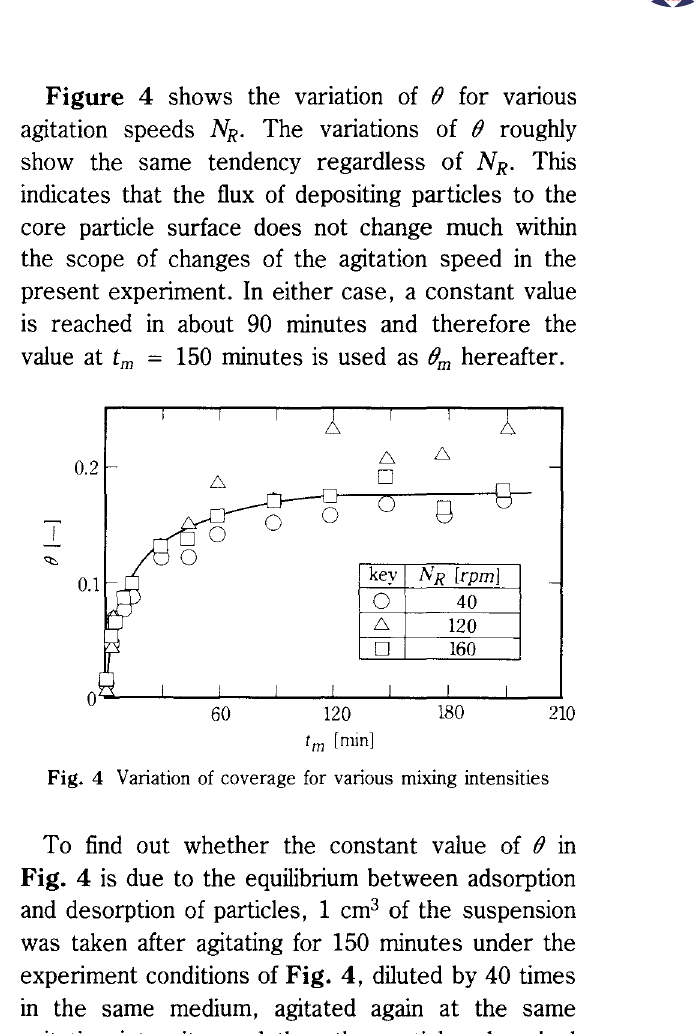
Fig. 4 Variation of coverage for various mixing intensities To find out whether the constant value of (J in Fig. 4 is due to the equilibrium between adsorption and desorption of particles, 1 cm 3 of the suspension was taken after agitating for 150 minutes under the experiment conditions of Fig. 4, diluted by 40 times in the same medium, agitated again at the same agitation intensity, and then the particles desorbed from the core particle was counted. The results are shown in Fig. 5. Here, since the diluting factor is sufficiently large, the re-deposition of desorbed particles will be neglected. The positive value of the desorption ratio a indicates the particle desorption by agitation. At any agitation speed, and any agitation time td, the value of a is approximately 0. Hence it is considered that the effect of desorption is small enough to be neglected.